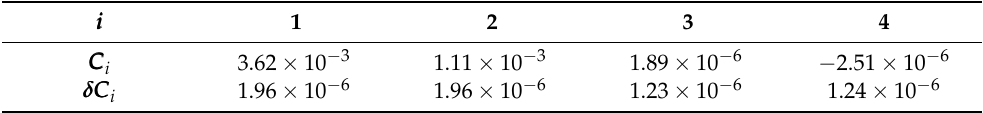
Figure 6. LSD logarithmic average of original differential measurements and the results after noise correction, and the OPD noise contribution. The noise floor is reduced from 2.76 × 10 − 10 m/ √ 3.86 × 10 − 11 m/ Hz at 100mHz after applying the noise correction algorithm. Table 1. Linear fitting coefficients and estimated fitting